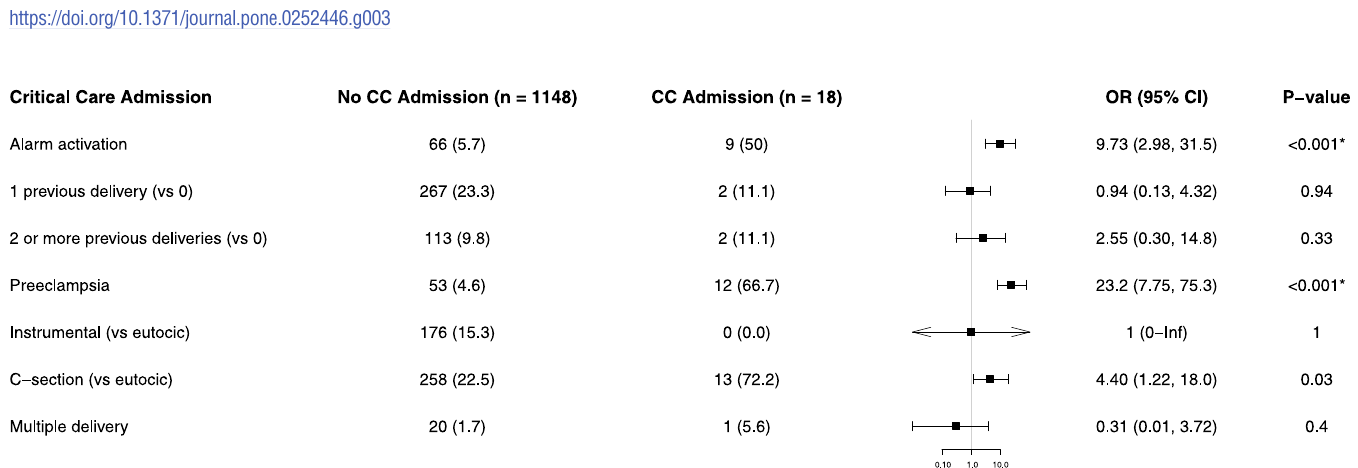
Fig 4. Forest plot of multivariate logistic analysis of the influence of MEWS activation, patient comorbidity and delivery on critical care unit admission. We present the results as an odds ratio with a 95% confidence interval. Results less than 1, left of the y-axis, imply risk reduction. We accepted p < 0.05 as significant.